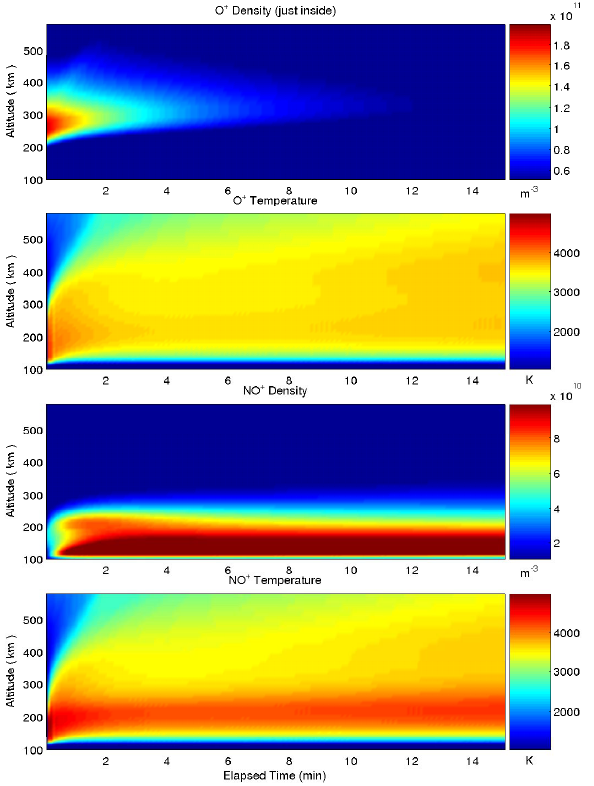
Fig. 5. Time evolution of electron parameters just on the edge of the arc, where the parallel current densities reach their peak values.